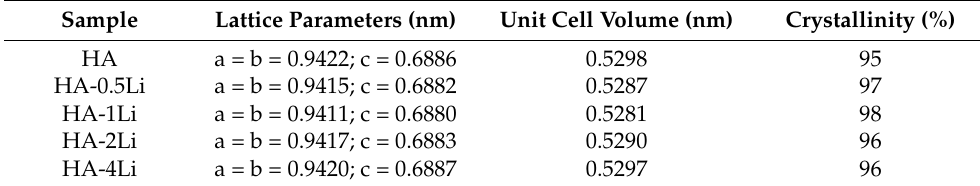
Figure 2. FTIR spectrum of: ( a ) HA. ( b ) HA-0.5Li. ( c ) HA-1Li. ( d ) HA-2Li. ( e ) HA-4Li sintered at 1250 °C. The FE-SEM micrographs in Figure 3 show the surface morphology of the synthe- sized powders by ball-milling before sintering at 1250 °C. It can be observed that the Li dopant had no considerable effect on the morphology and size of the HA nanoparticles. There are spherical agglomerates on the surface of larger particles possessing various size distributions. Figure 4 shows the FE-SEM micrographs of the fracture surfaces of samples after sintering. The Li-doped samples had heterogeneous microstructures, except for HA-